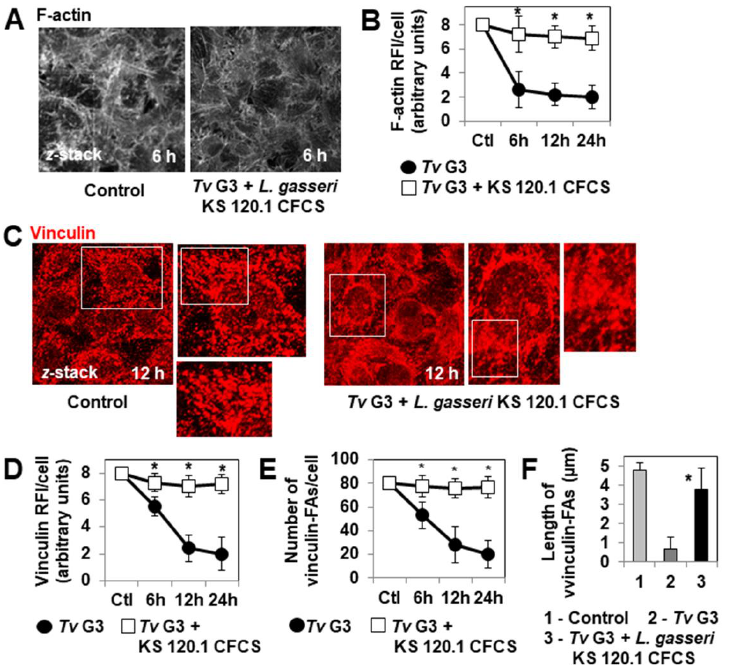
Figure 6. The strain-specific anti-trichomonadal activity of secreted L. gasseri KS 102.1 products abolishes Tv G3-induced alterations to the F-actin network and vinculin-positive focal adhesions. In ( A ), confocal laser scanning microscopy (CLSM) images of the F-actin network. In ( B ), change in F-actin relative fluorescence intensity (RFI) during the course of infection. In ( C ), representative CLSM images of vinculin-positive FAs. In ( D ), change in vinculin RFI/cell over the course of infection. In ( E ), change in the number of vinculin-positive FAs/cell over the course of infection. In ( F ), lengths of vinculin- positive FAs at 12 h post-infection. The micrographs shown are representative of three independent experiments. CFCS: cell-free culture supernatant. Ctl: Control. Each value shown is the mean ± SD of three independent experiments. In ( B , D – F ), * p < 0.01 in comparisons with Tv